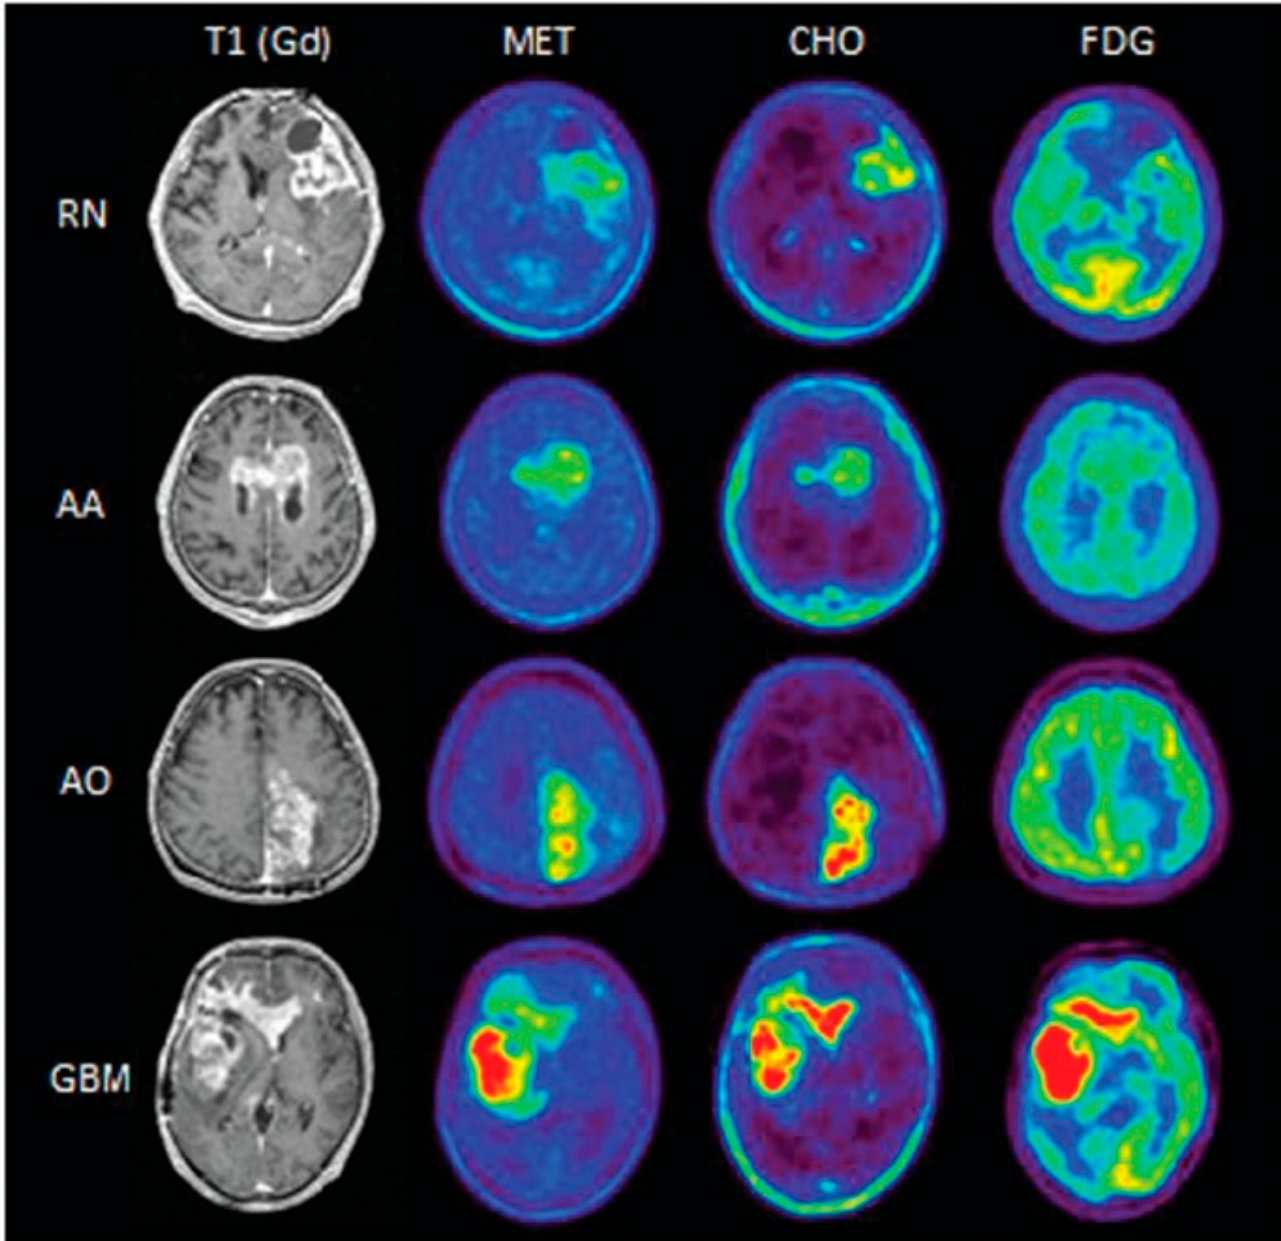
Figure 4. Comparison of the appearance of the findings of radiation necrosis (RN), anaplastic astrocytoma (AA), anaplastic oligodendroglioma (AO), and glioblastoma (GBM) between the different methods. Reprinted/adapted with permission from Ref. [17]. Copyright © 2014 The Japan Neurosurgical Society.